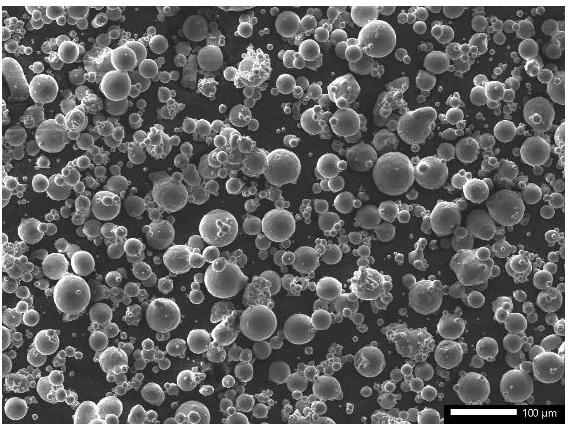
Figure 1. Morphology of gas-atomized Al6061 powder. SEM image.